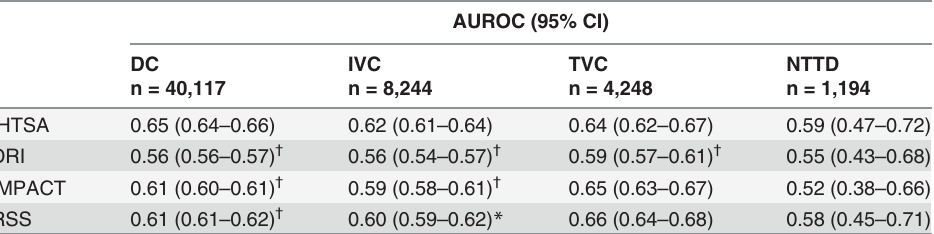
* p < 0.05 † p < 0.001 compared with ITHSA. AUROC, area under the receiver operating curve; CI, con fi dence interval; DC, derivation cohort; DRI, donor risk index for transplantation (reported in the paper by Weiss et al. [6]); IMPACT, index for mortality prediction after cardiac transplantation (reported in the paper by Weiss et al. [7]); ITHSA, international heart transplantation survival algorithm; IVC, internal validation cohort; NTTD, Nordic thoracic transplantation database; RSS, risk strati fi cation score (reported in the paper by Hong et al. [9]); TVC, temporal validation